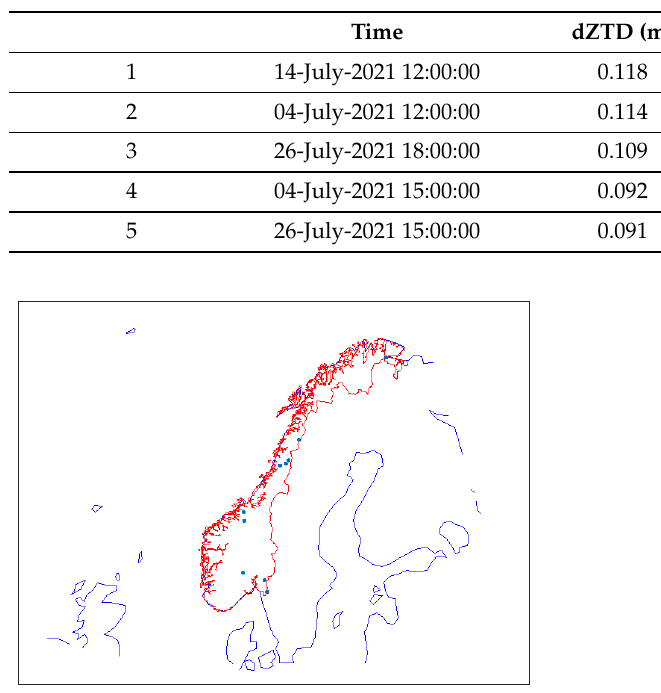
Table 3. List of dZTD events in Norway.